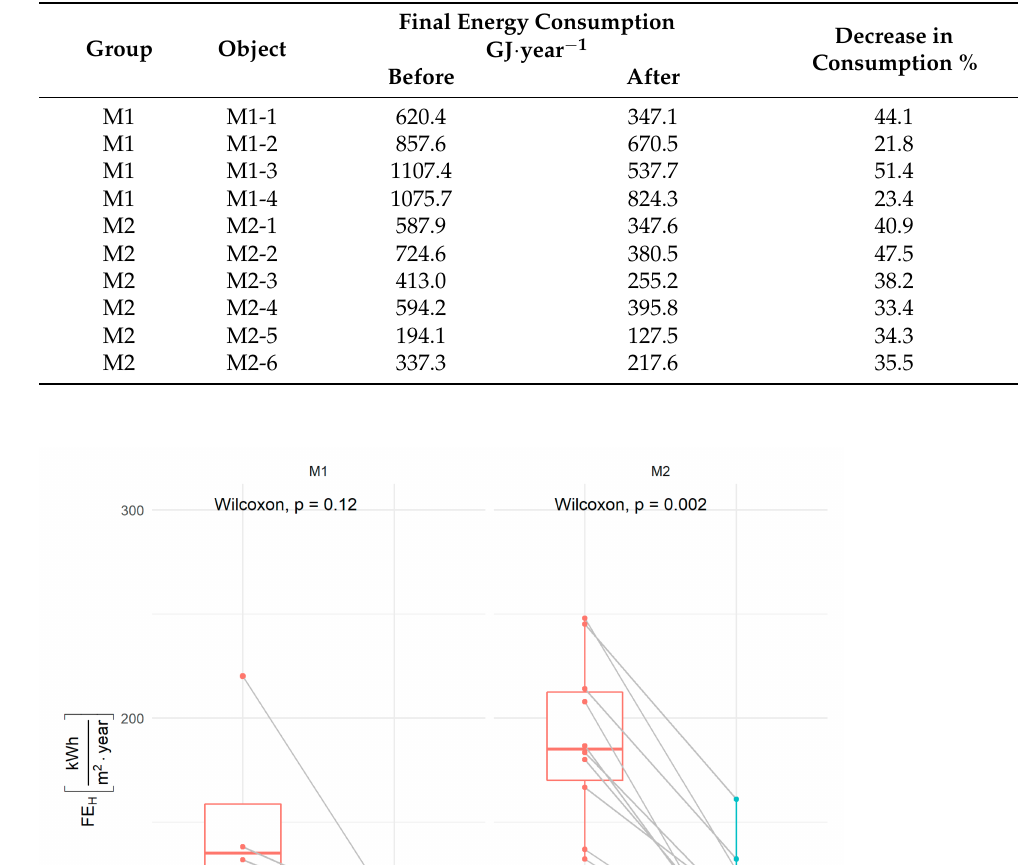
Table 7. Consumption and decrease in final energy consumption for heating.